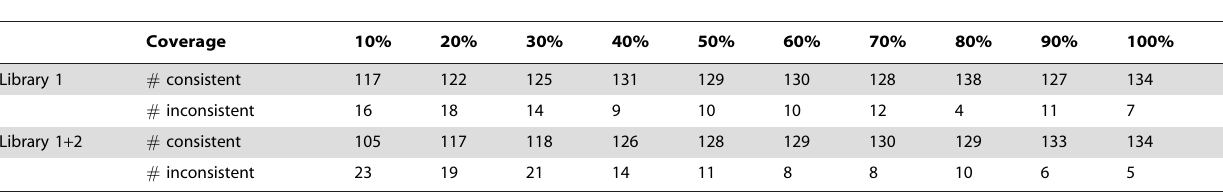
Table 5. Relationship between CDS consistency and the sequence coverage.